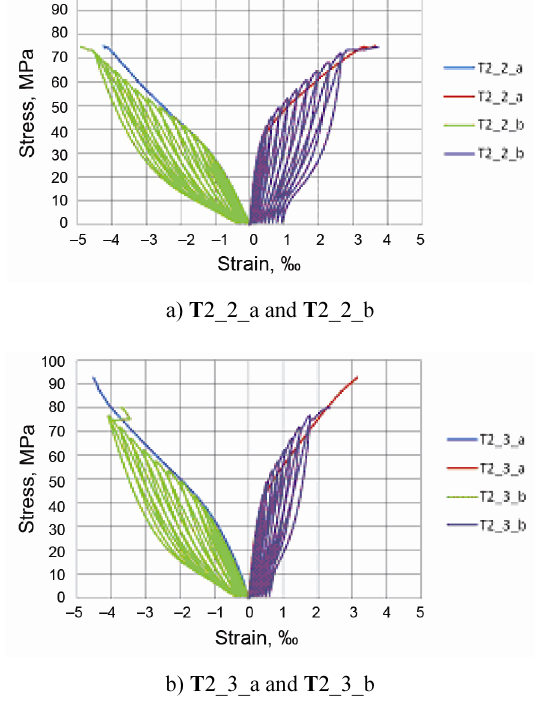
Fig. 17 . Cyclic and monotonic stress-strain curves for the T 2_2_a/b and T 2_3_a/b specimens